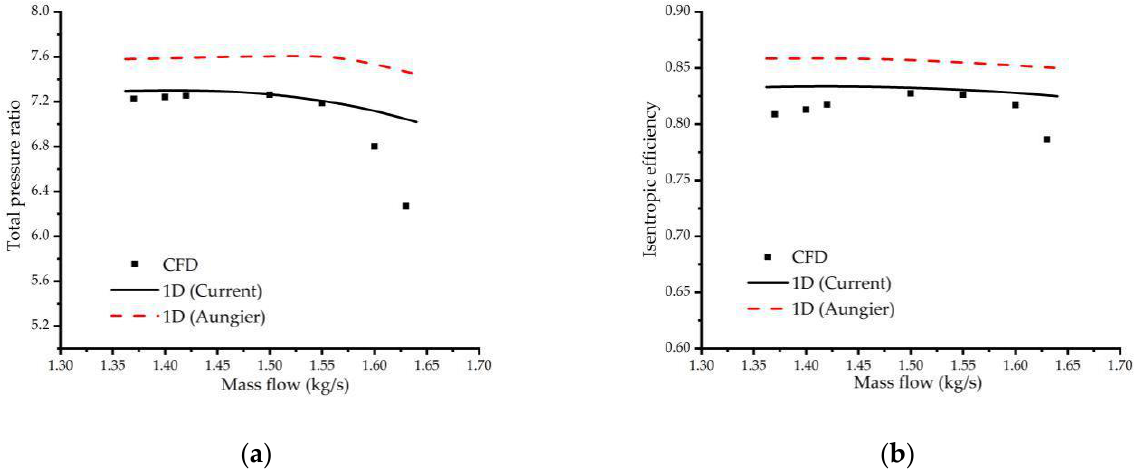
Figure 8. Performance comparison for two methods for Impeller J: ( a ) Total pressure ratio; ( b ) Isentropic efficiency .